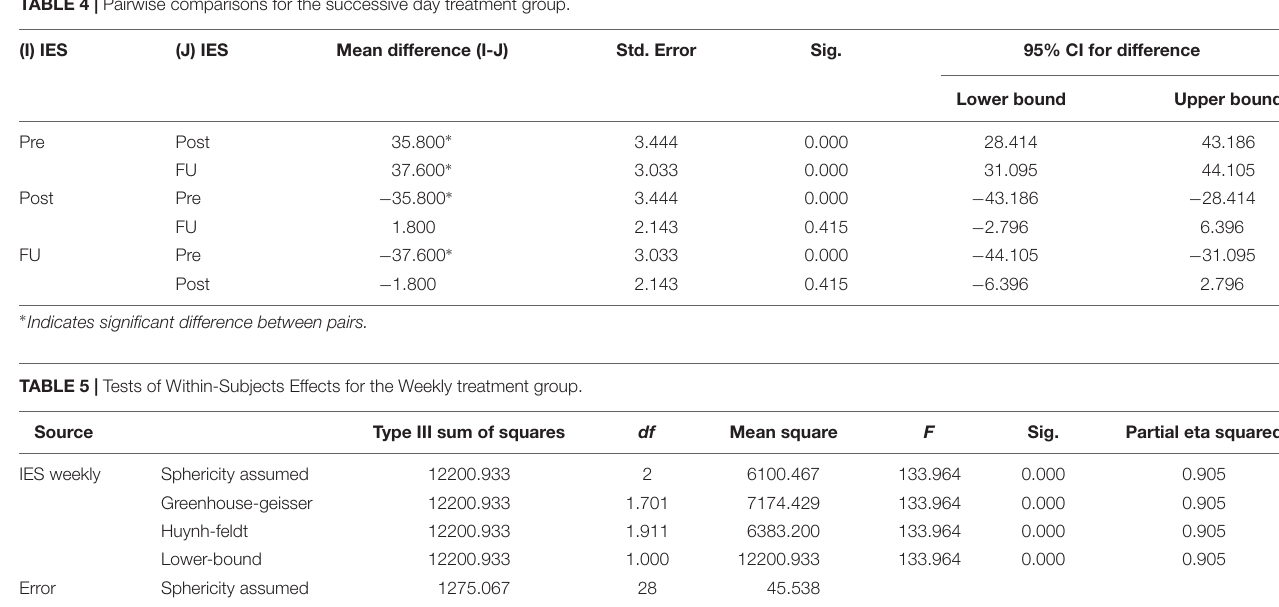
TABLE 4 | Pairwise comparisons for the successive day treatment group.